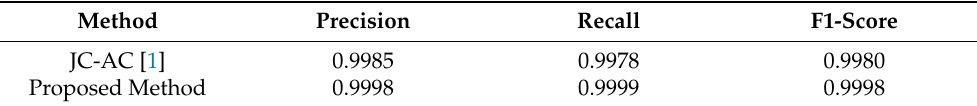
Table 4. Performance comparisons of the proposed method and related ICS anomaly detection methods for the binary-class (i.e., normal-anomalous) case.